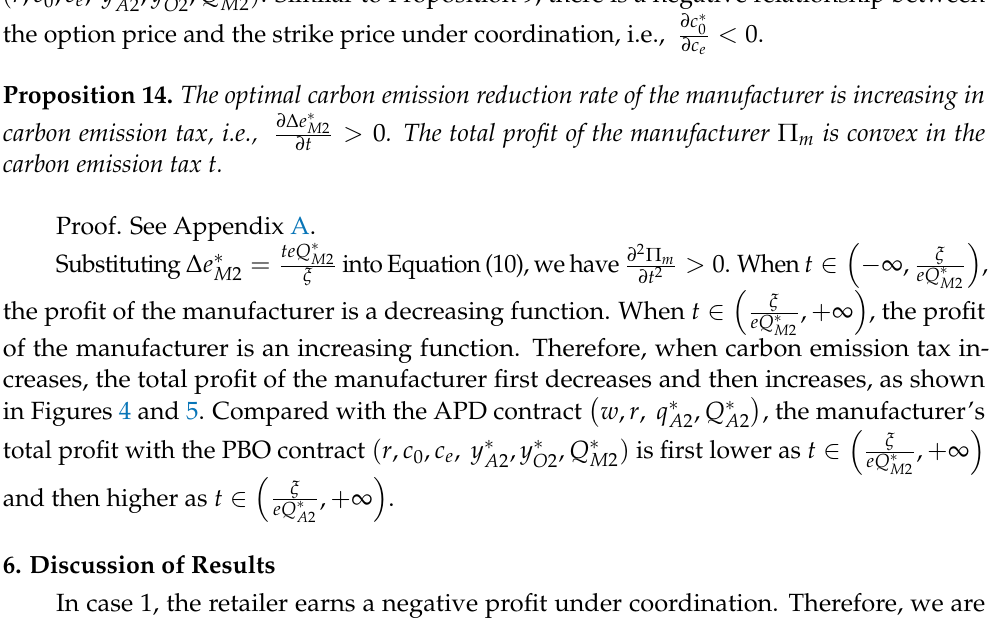
Table 7. Risk-sharing of partners under the PBO contract ( r , c 0 , c e , y ∗ Actual Demand Manufacturer Retailer